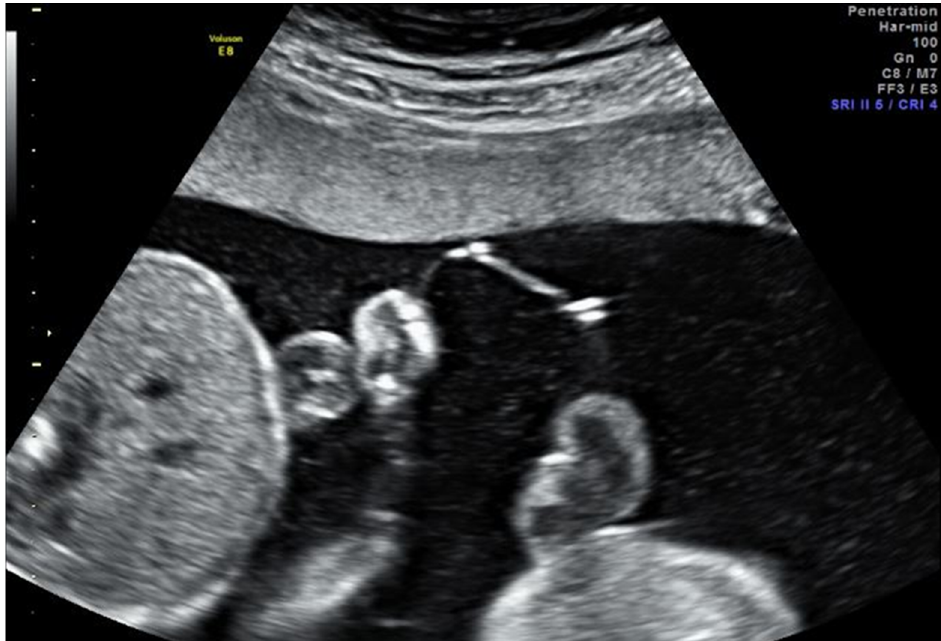
Figure 1. Ultrasound image the day after fetoscopic laser photocoagulation (FLP) showing the intervening membranes with a small defect, fluid equilibration between sacs, and similar fluid echogenicity between sacs.